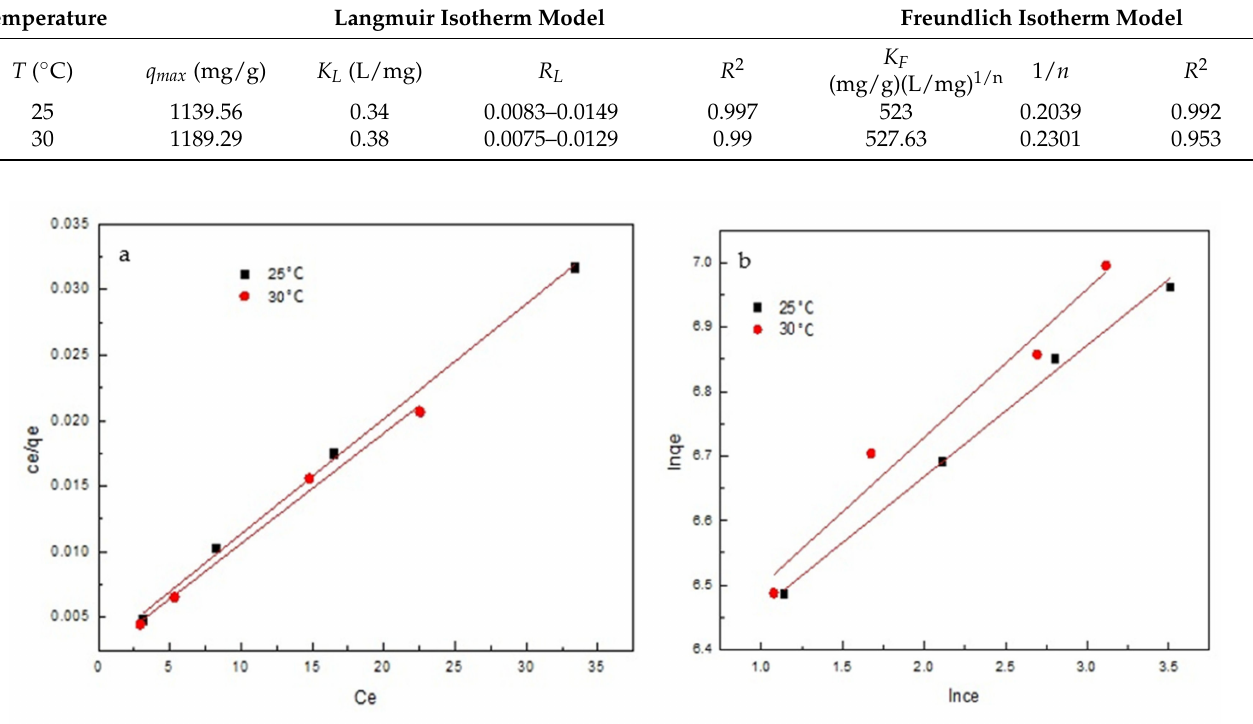
Figure 12. The Langmuir ( a ) and Freundlich ( b ) models for the adsorption of sulfonated lignite by filter paper-templated Mg-Al metal oxides at 25 and 30 ◦